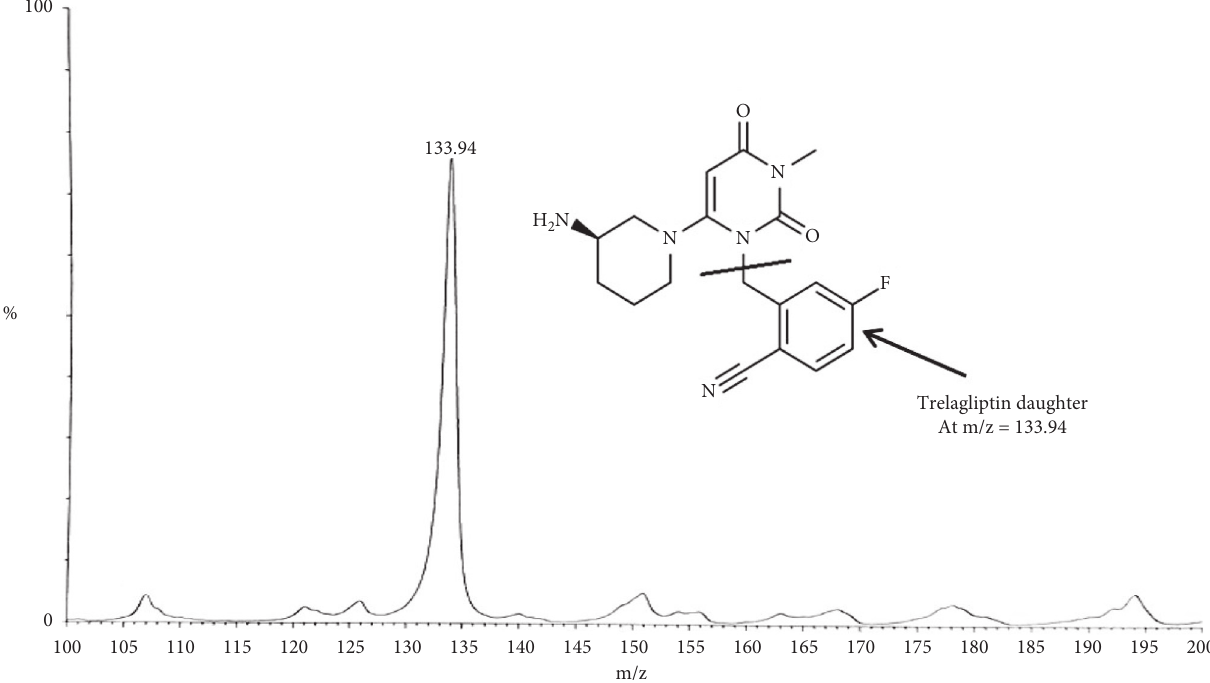
Figure 3: TLN daughter ions (+ESI) at m/z � 133.94.